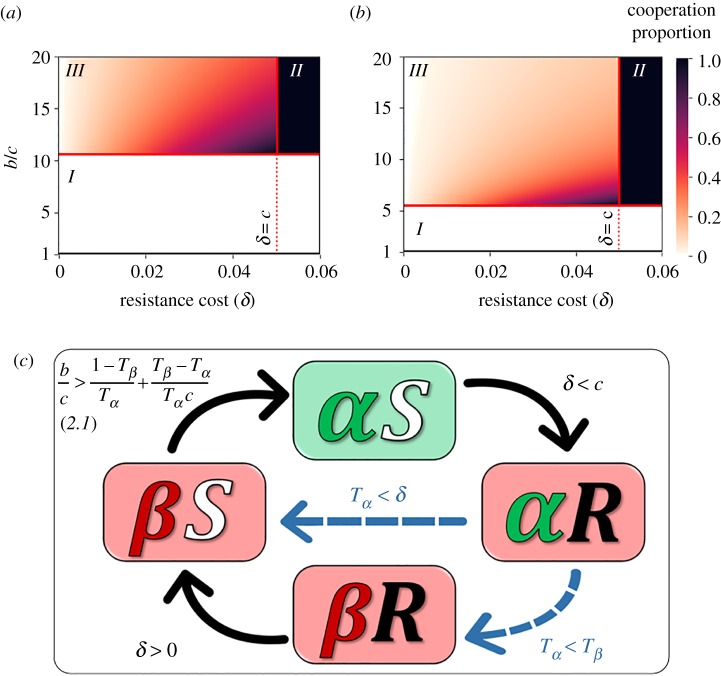
Cooperation can be maintained at intermediate levels even in the presence of host resistance to the microbial effect. (a,b) The expected proportion of cooperative hosts (αS; colour coded), as a function of b/c (y-axis) and δ (x-axis) for c = 0.05, Tβ = 0.25, and (a) Tα = 0.75 · Tβ, (b) Tα = 0.9 · Tβ. Cooperation goes extinct when below the horizontal line representing condition (2.1) (area I, white). Above that threshold, cooperation can either go to fixation (when δ > c, area II, black), or be maintained at intermediate levels (when δ < c, area III). The expected proportions of all four host types are shown in electronic supplementary material, figure S3. (c) Rock–paper–scissors game of cooperation. Illustrated are the conditions that allow the invasion of a rare type to a population dominated by another type, based on invasion analysis (electronic supplementary material, S2). For example, if δ < c, then αR hosts can invade αS populations, and if Tα < Tβ then αR populations can be invaded by βR hosts. Altogether, cooperation will be maintained as long as all the conditions represented by black arrows are satisfied, in addition to at least one of the conditions represented by dashed blue arrows.